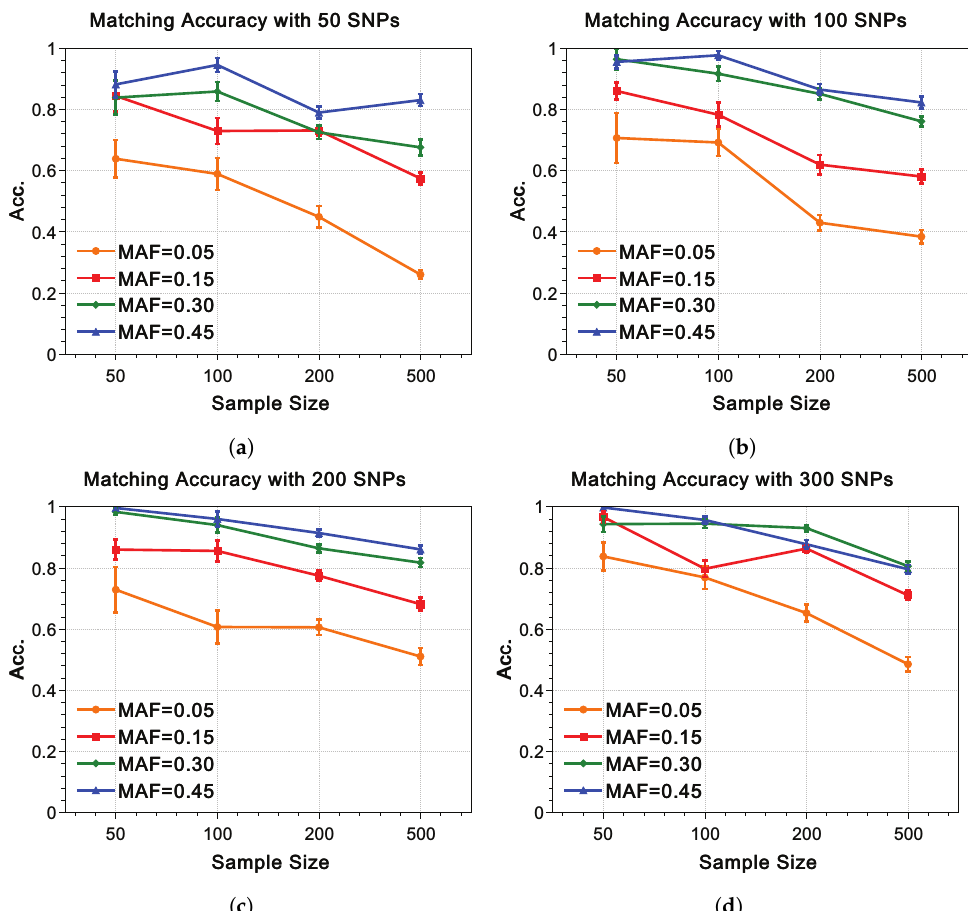
Figure 2. Matching accuracy with z score 2.33 for both z α and z β . The sample sizes n as 50, 100, 200, and 500 are expressed on the abscissa, respectively, while the matching accuracy is expressed on the ordinate. Matching accuracy with different MAFs and their standard deviations are expressed as different colored symbols with error bars, while the orange ellipse, red rectangle, olive diamond and blue triangle represent the MAF value of 0.05, 0.15, 0.30 and 0.45, respectively. The SNP sizes m of ( a – d ) are 50, 100, 200, and 300, respectively. ( a ) 50 SNP. ( b ) 100 SNP. ( c ) 200 SNP. ( d ) 300